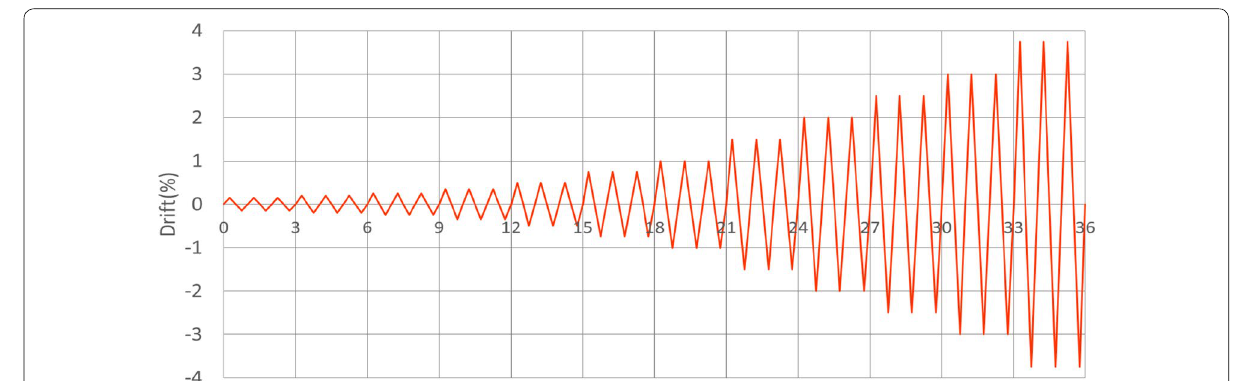
Fig. 8 Lateral loading